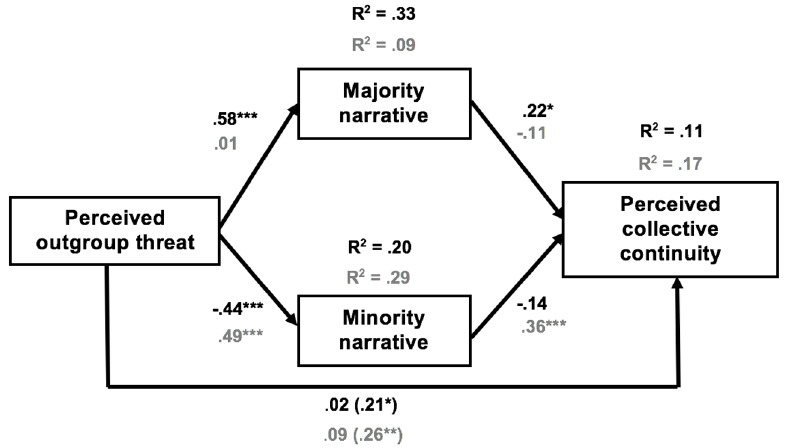
Figure 1. Path model results for Protestants (Majority, in black) and Catholics (Minority, in grey). Note. Influence of perceived outgroup threat on perceived collective continuity, via endorsement of majority and minority historical narratives. Path-coefficients are standardized estimates and the path coefficient in brackets reflects the standardized total